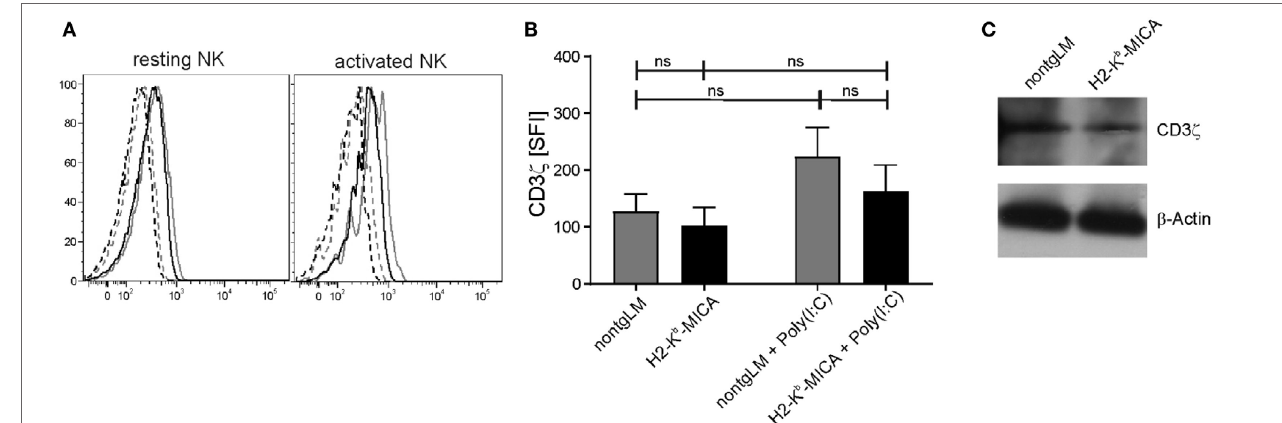
FigUre 3 | CD3 ζ expression in splenic H2-K b -MICA NK cells is not substantially altered. (a,B) Splenic NK cells from H2–K b –MICA mice and non-transgenic littermates (non-tgLM), respectively, were analyzed for CD3 ζ expression. Resting NK cells were from naïve mice, activated NK cells from mice injected with poly(I:C) 16 h prior to analysis. Splenocytes were permeabilized and stained for CD3 ζ (mAb 6B10.2) by flow cytometry. (a) Representative CD3 ζ stainings of resting (left) or activated (right) NKp46 + splenocytes from a H2–K b –MICA mouse (black solid line) and from a non-tgLM (gray solid line) overlayed with the corresponding isotype controls (stippled lines). (B) Summarized data from three mice per group analyzed in parallel showing means of specific fluorescence intensities (SFIs) plus SDs. Two-way ANOVA was performed with a Tukey posttest to assess statistical significance (ns = not significant). (c) Immunoblot analysis of lysates of freshly purified splenic NK cells from naïve H2-K b -MICA and non-tgLM mice with anti-CD3 ζ mAb 6B10.2. Purified NK cells from three mice per group were pooled for analysis. Actin was probed for control. One representative of three experiments is shown.